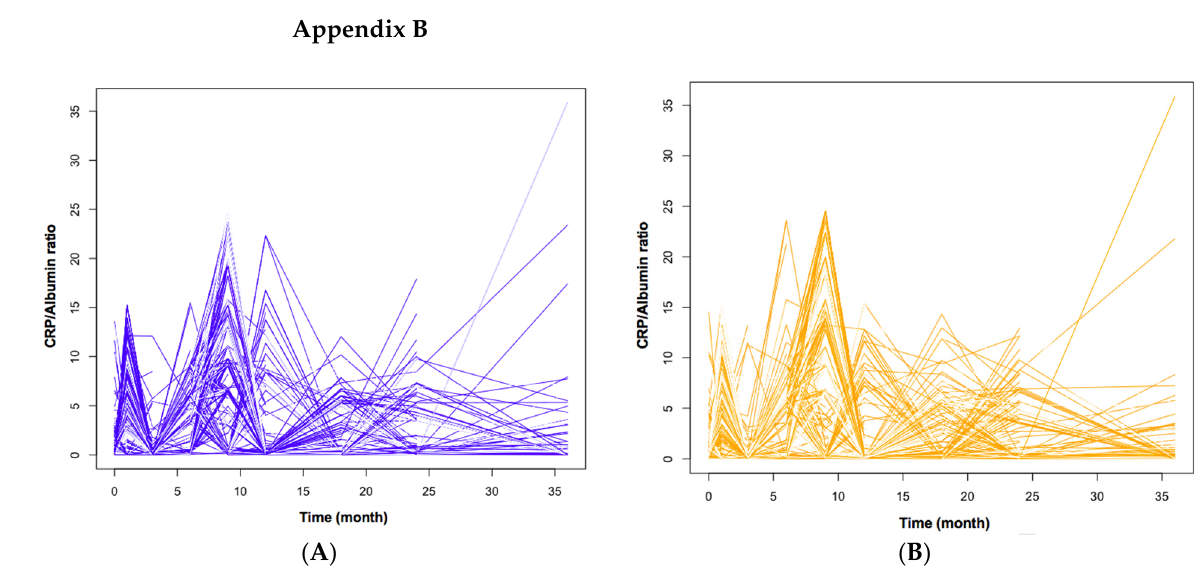
Figure A1. ( A ): Individual trajectories for cluster A. ( B ): Individual trajectories for cluster B. Cancers 2021 , 13 , x FOR PEER REVIEW